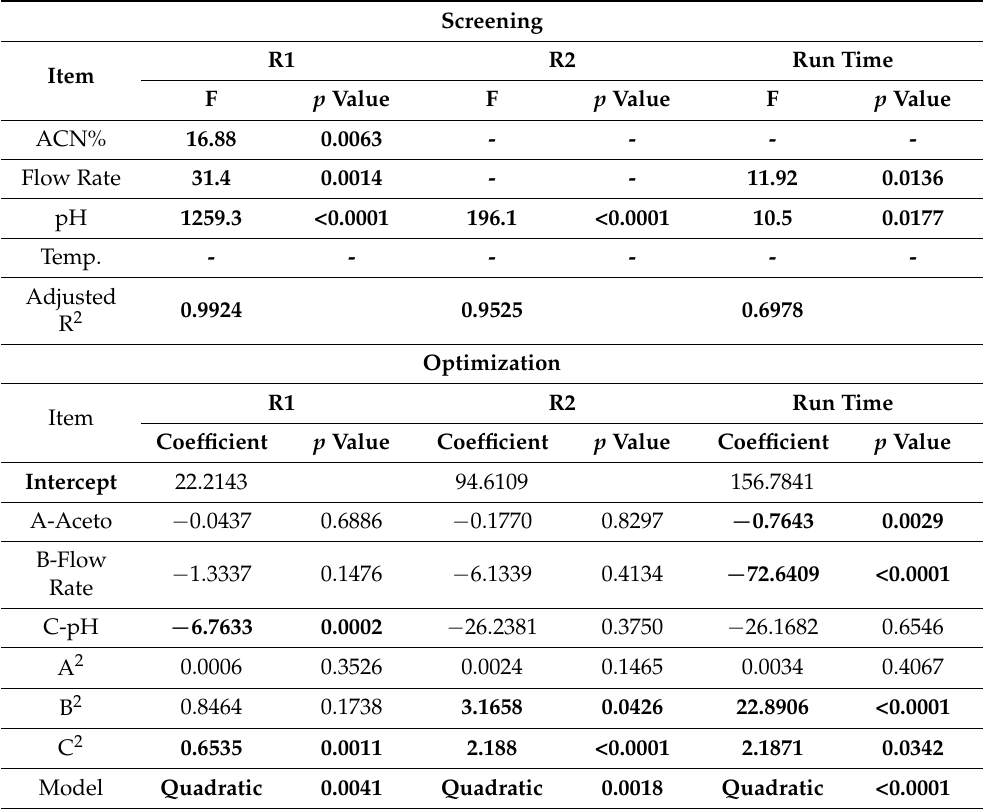
Table 1. ANOVA and regression parameters of the fractional factorial design and central composite design (the insignificant interaction effects are not